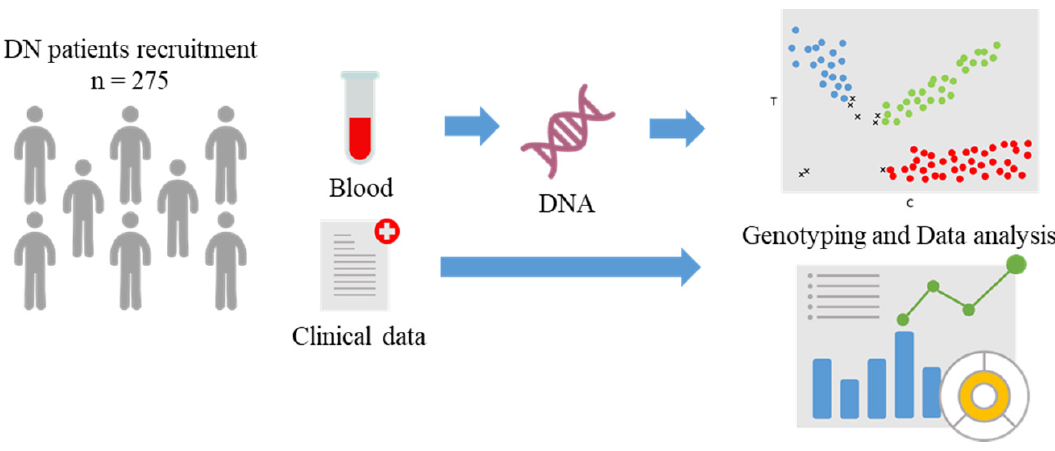
Figure 1. A workflow for Genetic Association Studies.